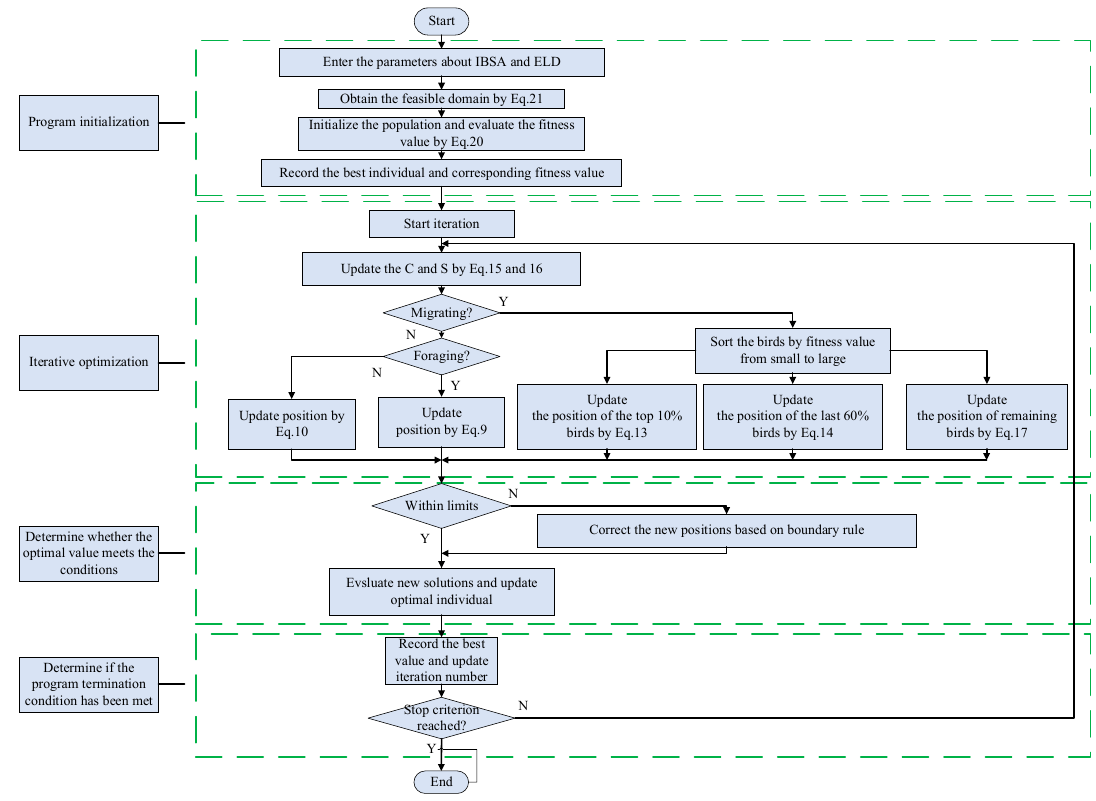
Figure 1. Flowchart of the IBSA for solving the Economic Load Dispatch (ELD) problem.